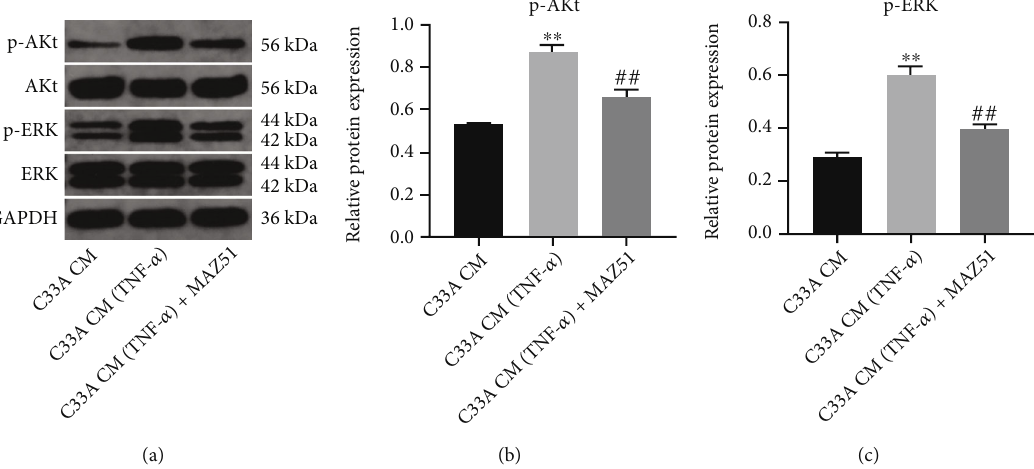
Figure 4: CM-TNF- α upregulates the expressions of p-AKT and p-ERK of HLECs. C33A cells were stimulated with 10ng/ml TNF- α for 48h, and the CM was collected. Next, HLECs were cultured in CM with or without MAZ51 treatment. (a – c) The levels of AKT, p-AKT, ERK, and p-ERK of HLECs were measured by western blot. ∗∗ P < 0 : 01 compared with CM group; ## P < 0 : 01 compared with CM-TNF- α group, n = 3